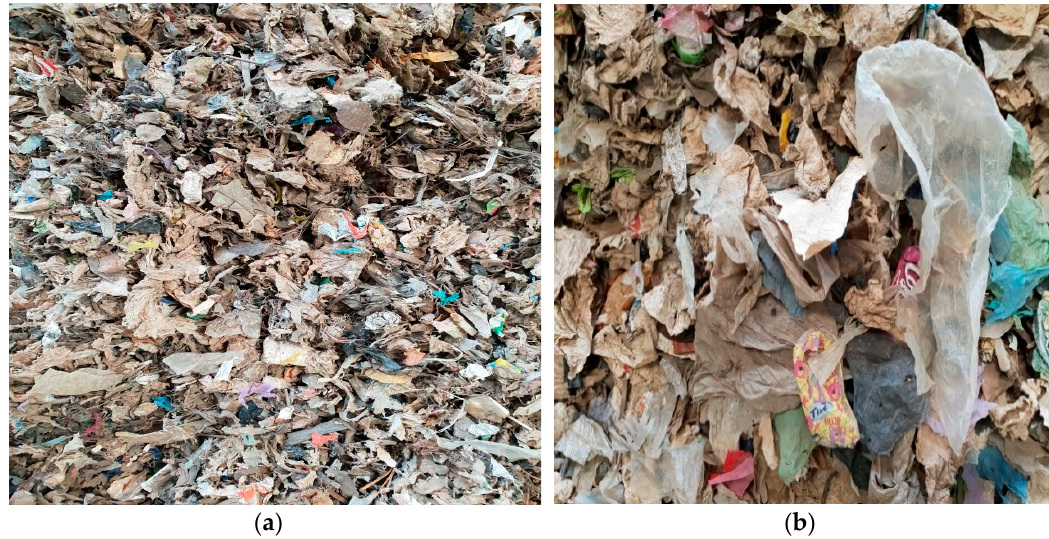
Figure 2. High-energy fractions separated from the CLO: ( a ) after the Zig-Zag separator (M-1); ( b ) after the NIHOT (M-2) separator.